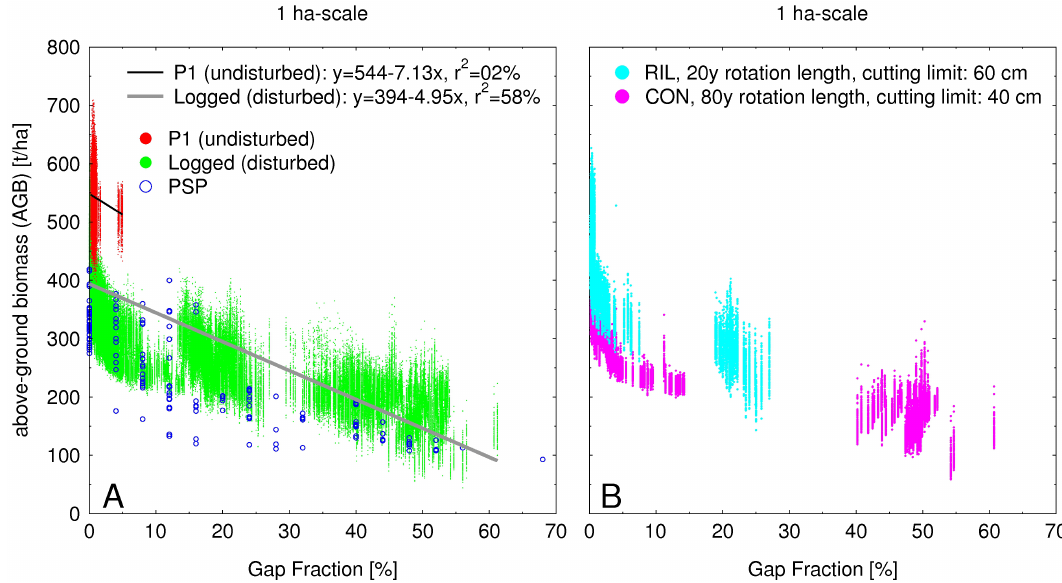
Fig. 7. Relation between above-ground life biomass (AGB) and gap fraction. Gaps are defined as individual 20m × 20m plots with canopy height h < 25m. (A) Undisturbed forest P1 (red), disturbed forests of all logging scenarios (green), and permanent sampling plot data (PSP, blue). (B) Two specific examples for logging are highlighted: Cyan: reduced-impact logging, 80y return interval, minimal dbh of logged trees = 60cm. Magenta: conventional logging, 20y return interval, minimal dbh of logged trees =